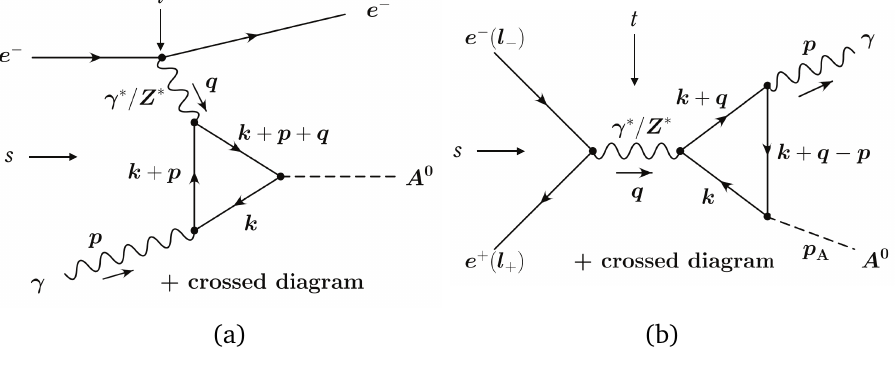
Figure 1: CP-odd Higgs A 0 production in (a) e γ and (b) e + e −